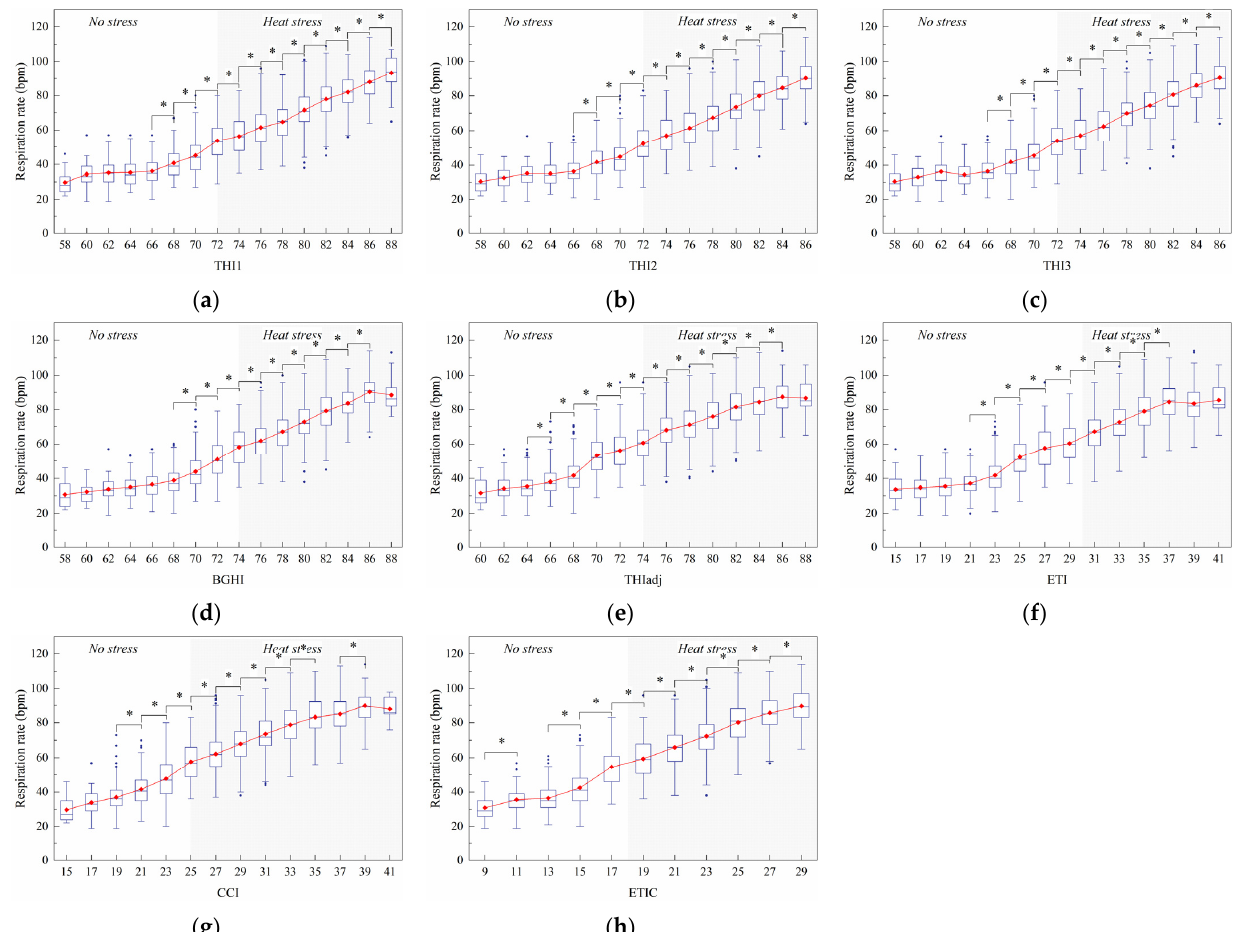
Figure 7. Effect of the thermal index values on respiration rate. The interquartile range (IQR) is shown by a blue box, the median as a blue horizontal line, the mean as a red square, and the whiskers extend to 1.5 IQR. Outliers are indicated by blue dots. An asterisk indicates a significant ( p < 0.05) change in the variable. The thermal indices are temperature–humidity index (THI1 ( a ), THI2 ( b ), THI3 ( c )), black globe humidity index (BGHI ( d )), adjusted THI (THIadj ( e )), equivalent temperature index (ETI ( f )), comprehensive climate index (CCI ( g )), and equivalent temperature index for dairy cattle (ETIC ( h )).